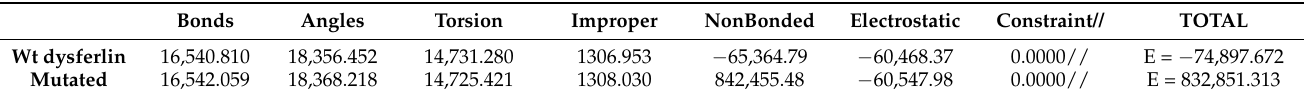
Table 3. Energy values (KJ/mole) of Wild type (Wt) and mutated